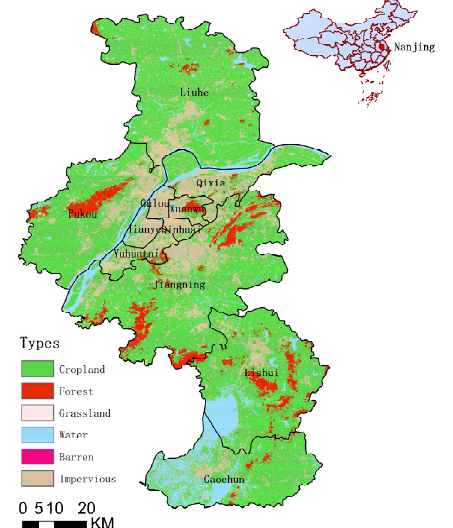
Figure 1. The land use cover map of Nanjing.